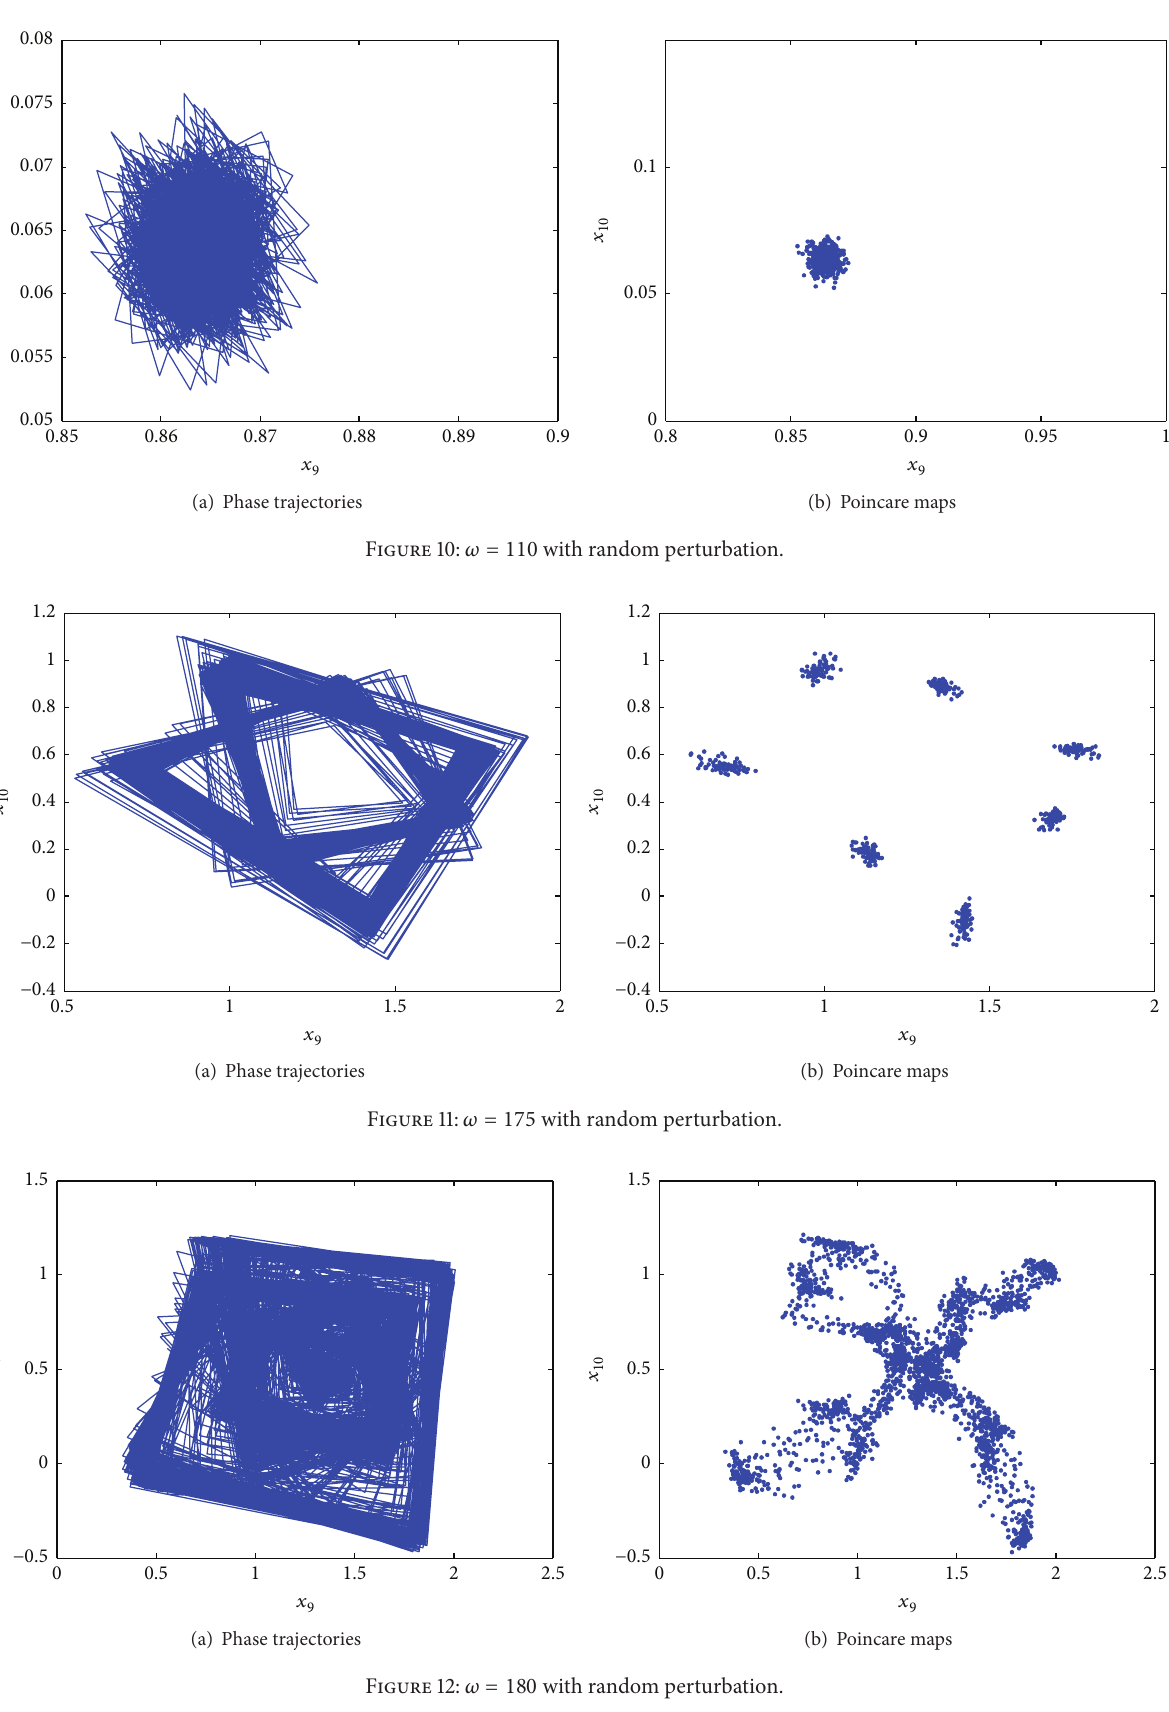
Figure 12: 𝜔 = 180 with random